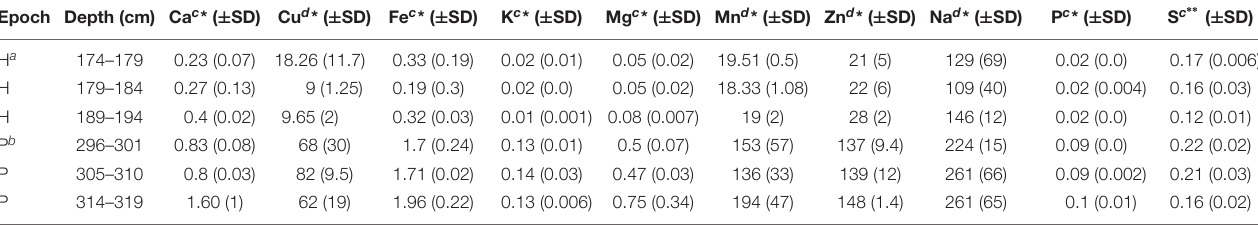
TABLE 2 | Measured dissolved metals of the selected segments for microbial analysis.